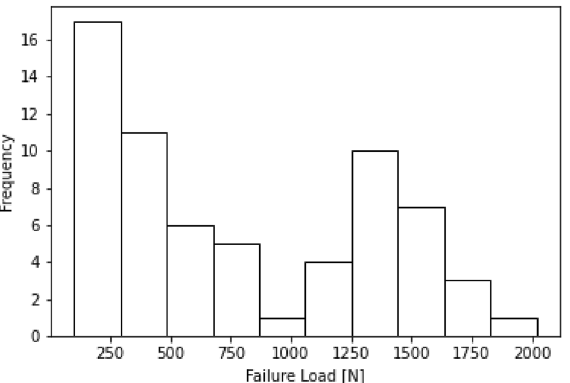
Figure 5. Histogram showing the range of failure loads measured during the biomechanical testing of the porcine